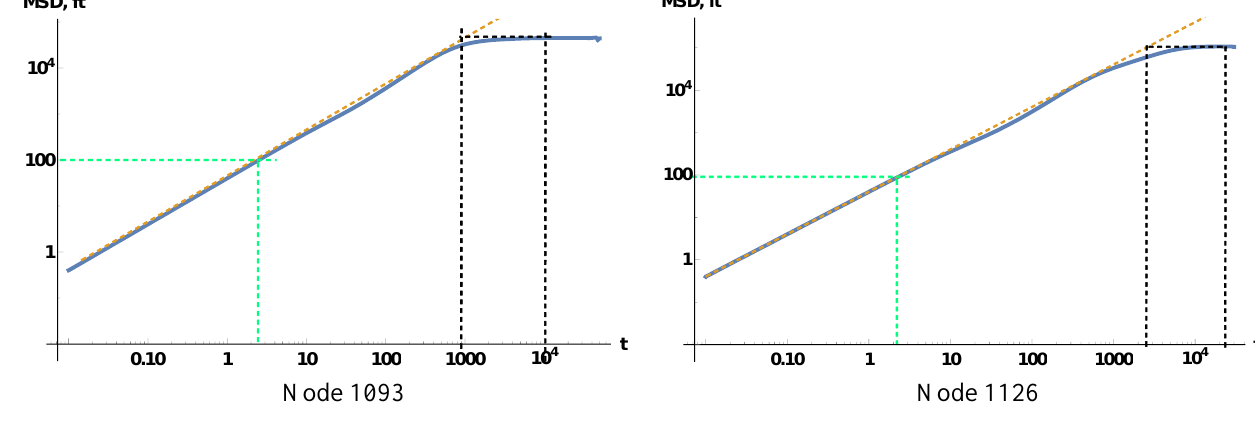
Figure 5—log-log plots of MSD vs. time for 10 sampled nodes in Case 0. Case 1.